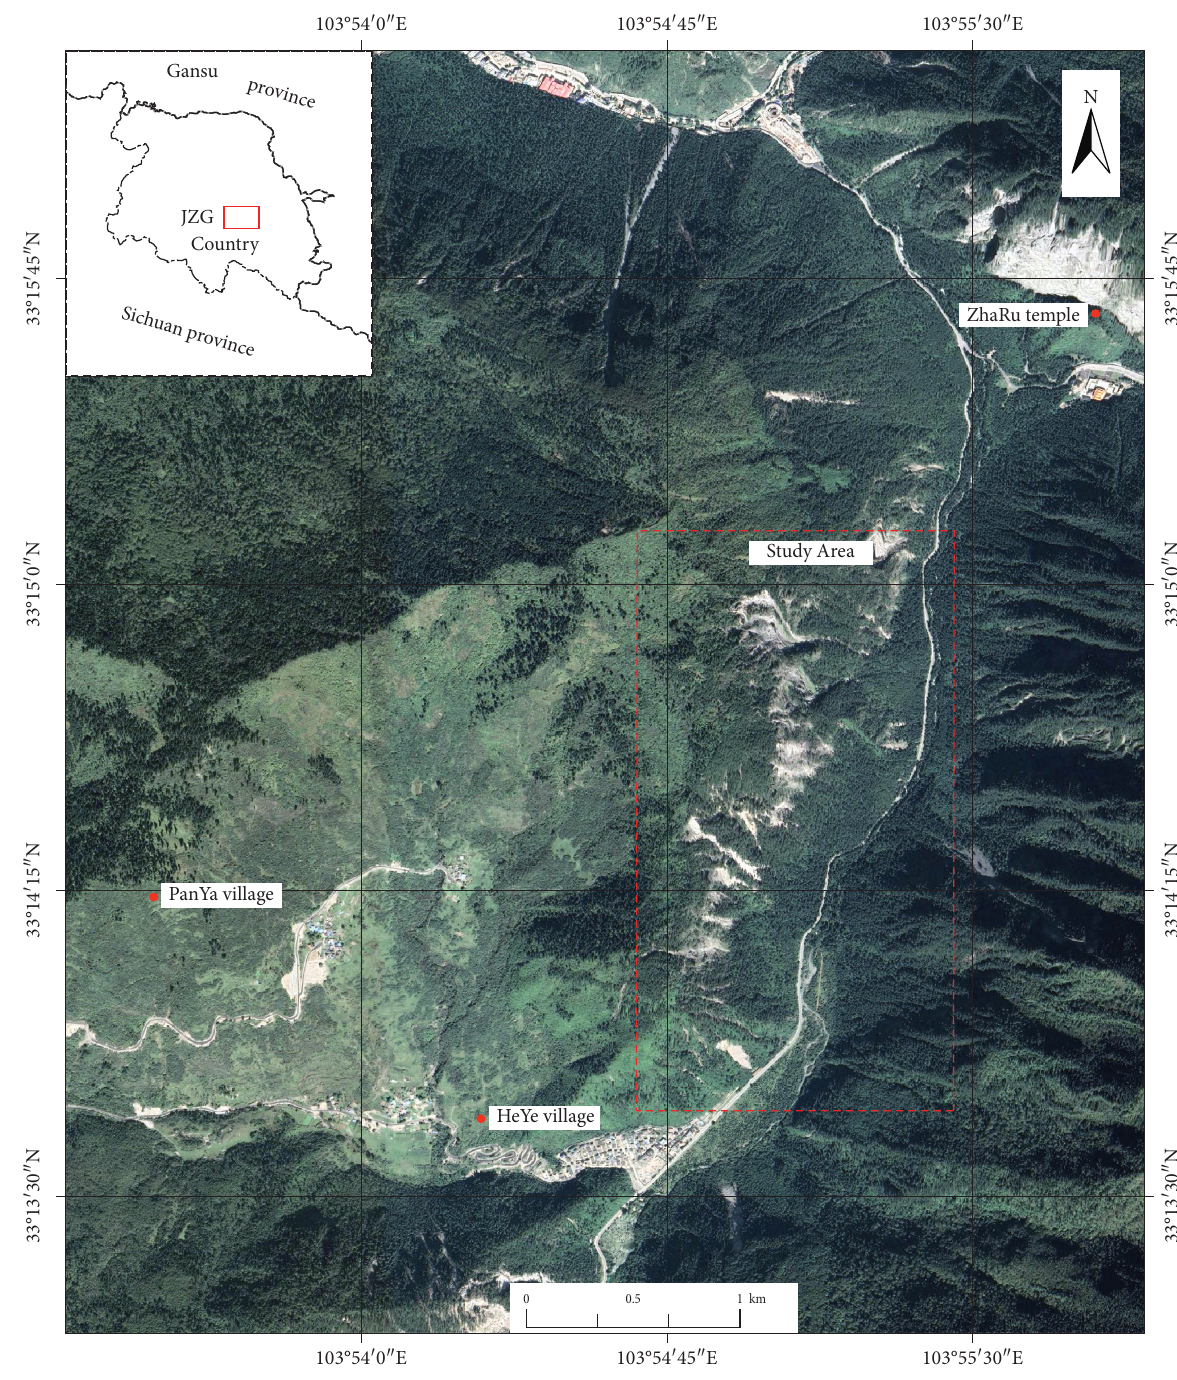
Figure 1: The map of study area. The red dotted box is the scope of the study area, where vegetation damage caused by the earthquake caused a collapse, threatening the road directly